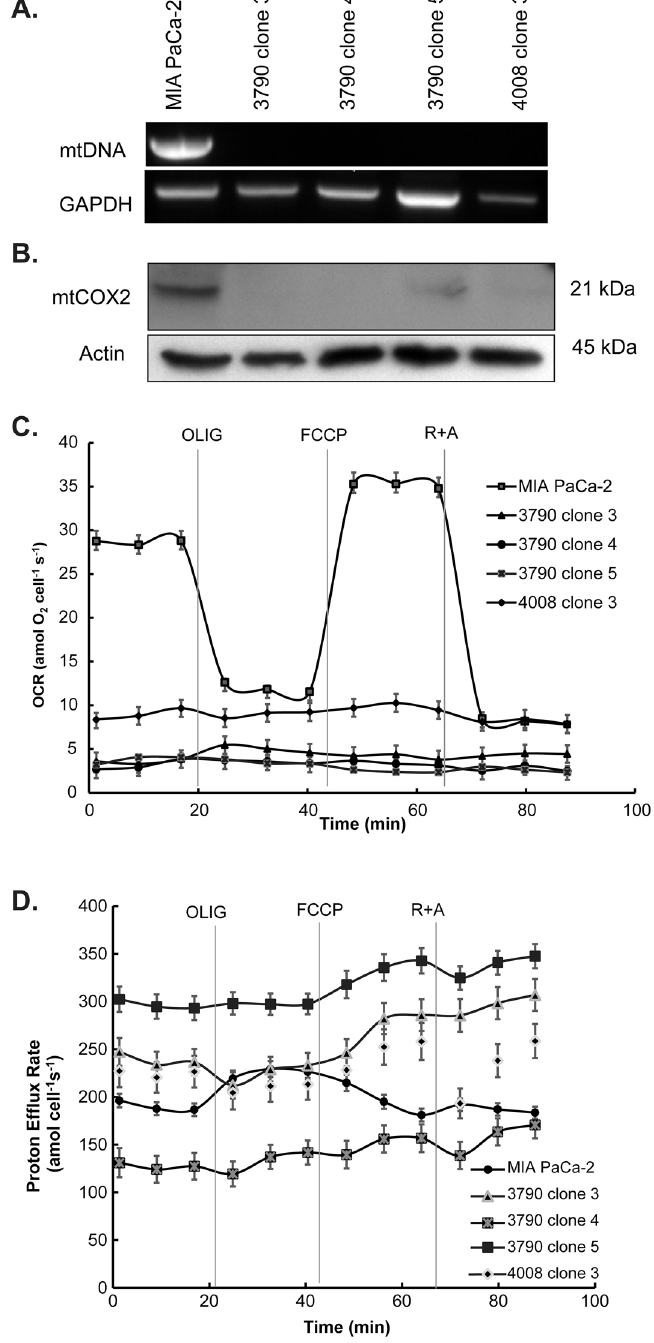
Figure 1. Characterization of ρ 0 cells. ( A ) PCR analyses demonstrate intact mtDNA in the wild-type MIA PaCa-2 cell line but depletion of mtDNA in ρ 0 cells. ( B ) Western blot analyses demonstrate expression of the mitochondrial DNA encoded protein cytochrome c oxidase subunit 2 (mtCOX2) is absent in the ρ 0 clones. ( C ) Oxygen consumption rate (OCR) measured in MIA PaCa-2 and ρ 0 clones under basal conditions and following the injection of oligomycin A (OLIG), carbonyl cyanide-p-trifluoromethoxyphenyl-hydrazon (FCCP), and rotenone + antimycin A (R + A). Note the lack of changes in OCR with the various metabolic inhibitors in ρ 0 cells. ( D ) Proton Efflux Rates (PER) of MIA PaCa-2 and ρ 0 cells. The parental cell line as well as ρ 0 clones have differing glycolytic rates as reflected by proton efflux rates. Note that the parental cell line shows increased PER after oligomycin treatment to compensate for lost ATP production from oxidative phosphorylation. The ρ 0 clones have no response upon addition of oligomycin, consistent with the lack of oxidative